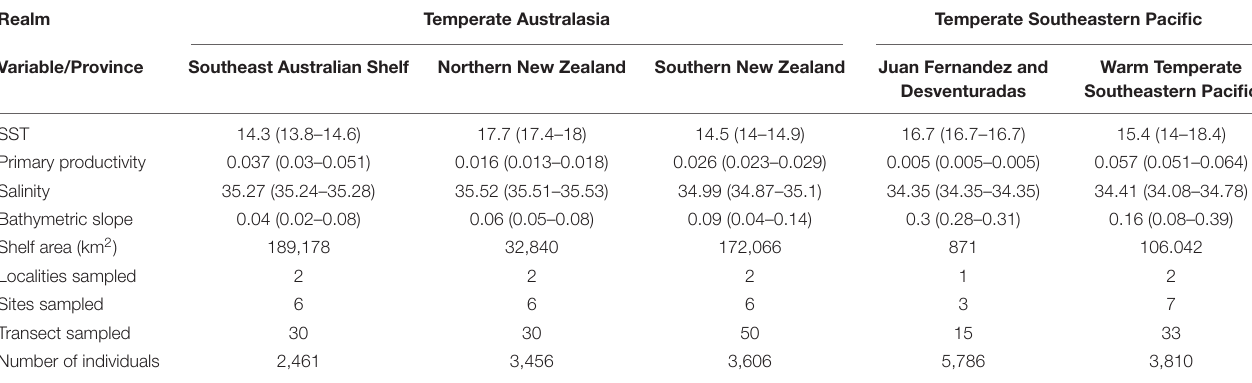
FIGURE 1 | Map of the study region showing locations of the five major marine biogeographic provinces. The domain is distributed across the temperate South Pacific Ocean, and includes samples from all provinces with temperate rocky reef habitat. TABLE 1 | Summary of the main biological and environmental characteristics of the study